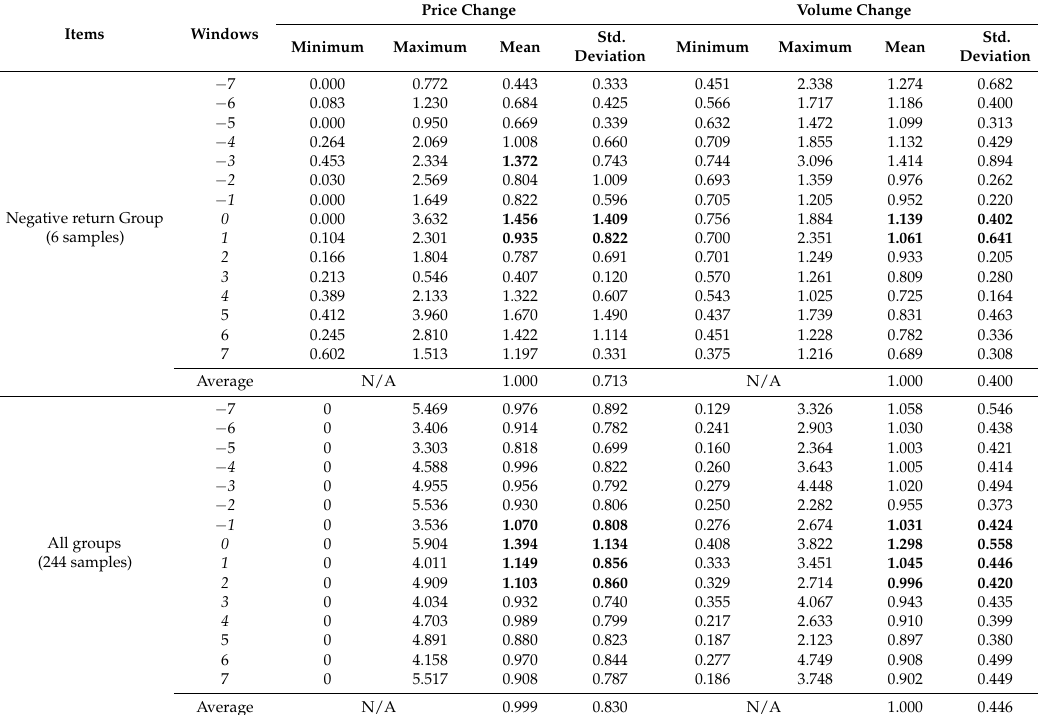
Table 4. Comparison between Negative Return Group and All Group (95% are positive earning companies): Descriptive